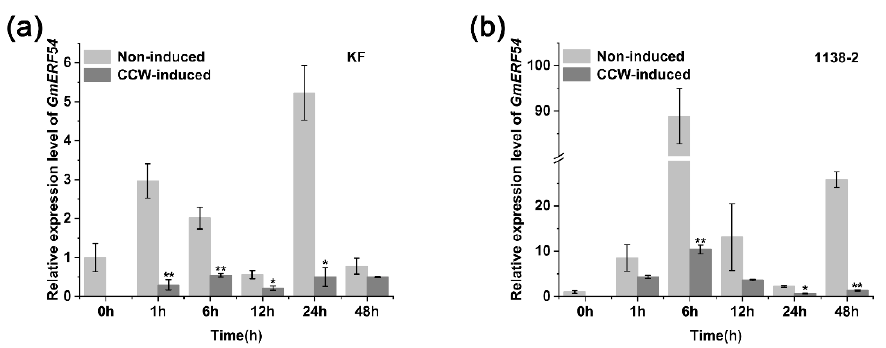
Figure 1. Relative expression levels of GmERF54 in non-induced and CCW-induced leaves of soy- bean plants at the V4 stage ( n = 3). ( a ) CCW-induced expression analysis of GmERF54 in KF (the insect-resistant accession). ( b ) CCW-induced expression analysis of GmERF54 in 1138-2 (the insect- susceptible accession). The qRT-PCR results were normalized to the tubulin control gene and rela-